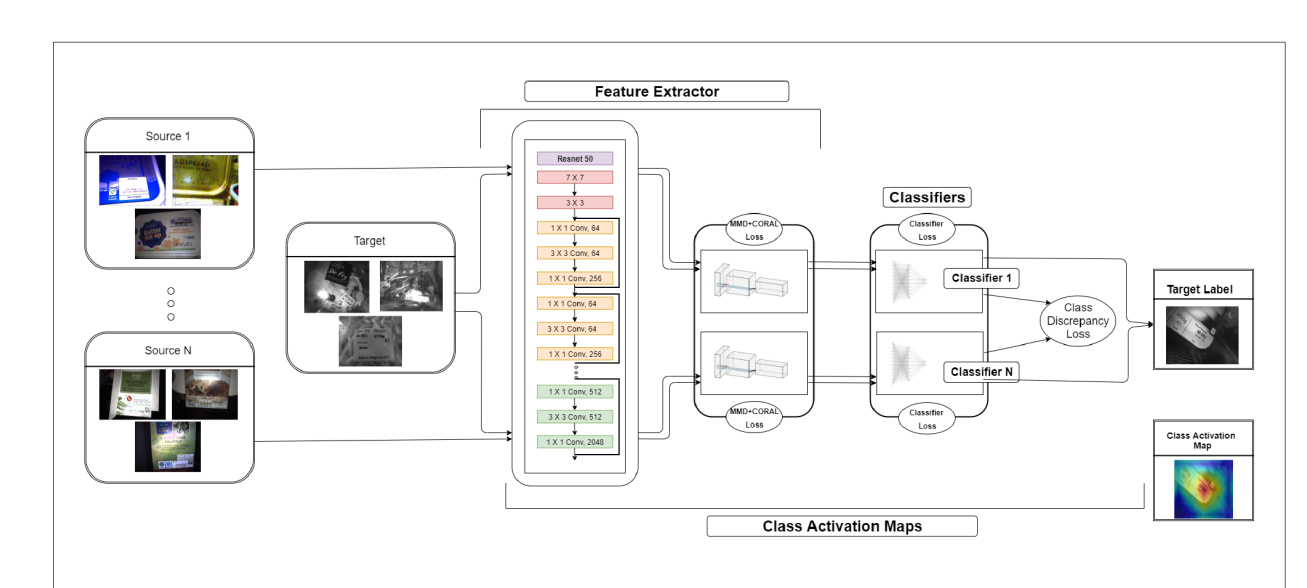
Figure 12. The Multi-source Domain Adaptation architecture.